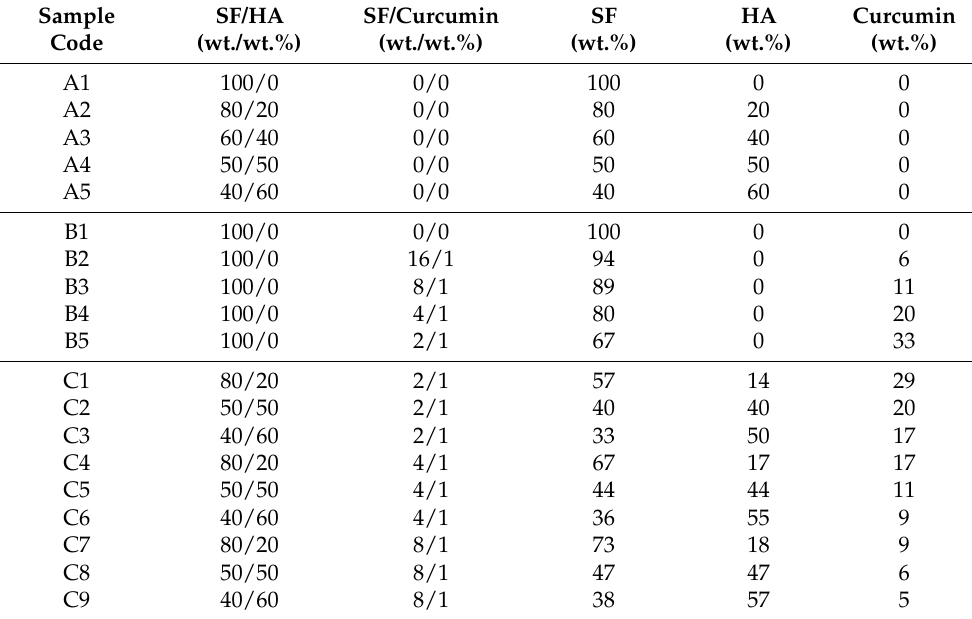
Table 1. Composition and nomenclature of the curcumin-loaded SF/HA hydrogels